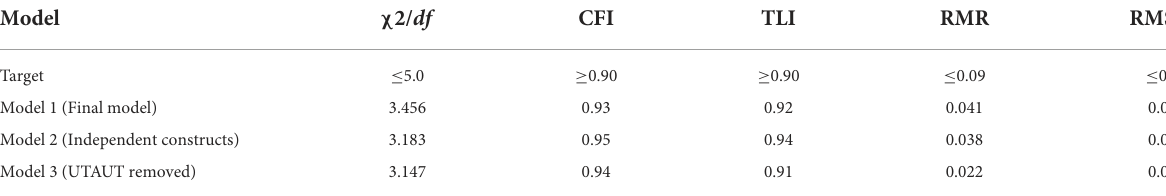
TABLE 2 Goodness fit indices for the measurement model.